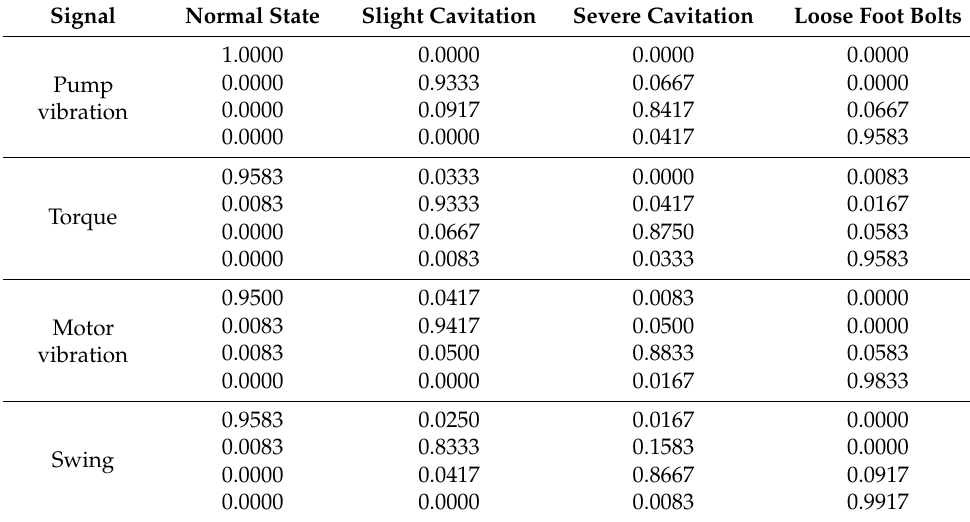
Table 1. Preliminary diagnosis results of BP neural network.